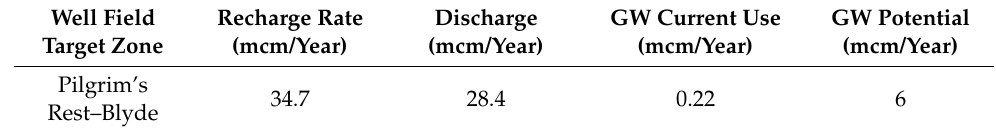
Table 1. Groundwater (GW) values for the Pilgrim’s Rest–Blyde well field target zone (WFTZ) used in the groundwater sub-model to inform the recharge rate, current use, discharge rate,